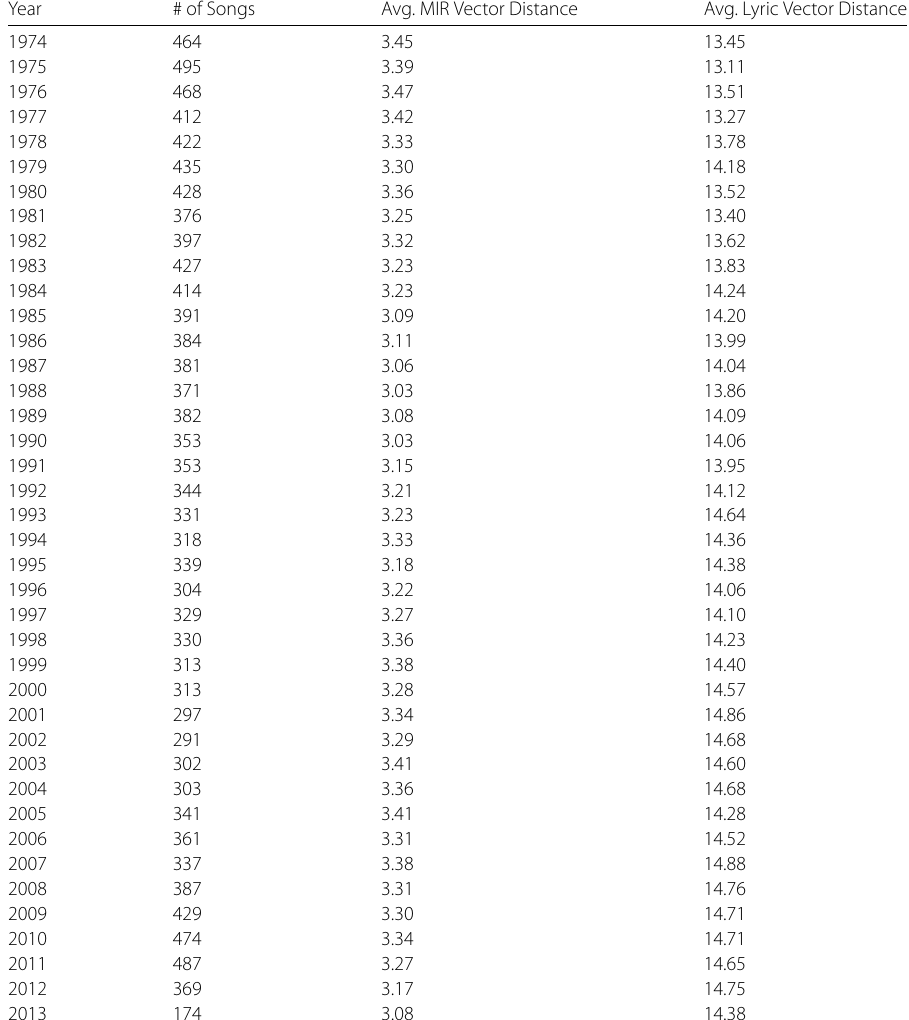
Table 1 Number of songs per year and average MIR and lyric vector distances across all genres Year # of